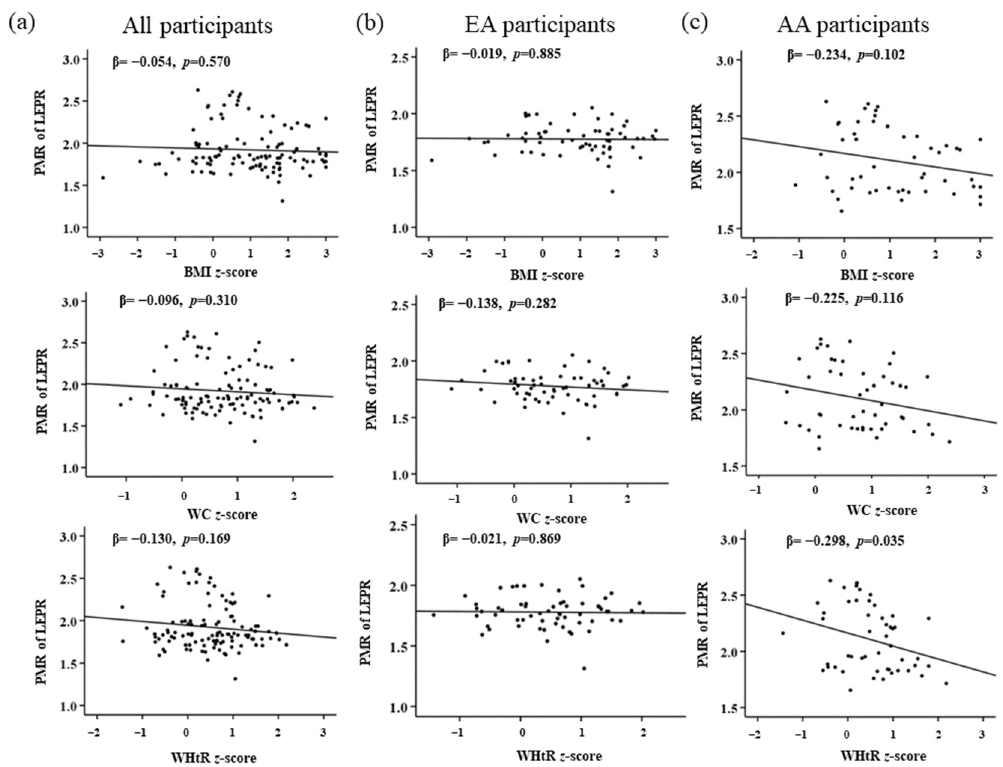
Figure 4. Association of LEPR with childhood obesity markers of ( a ) all, ( b ) EA, and ( c ) AA participants. p < 0.05 is considered statistically significant.